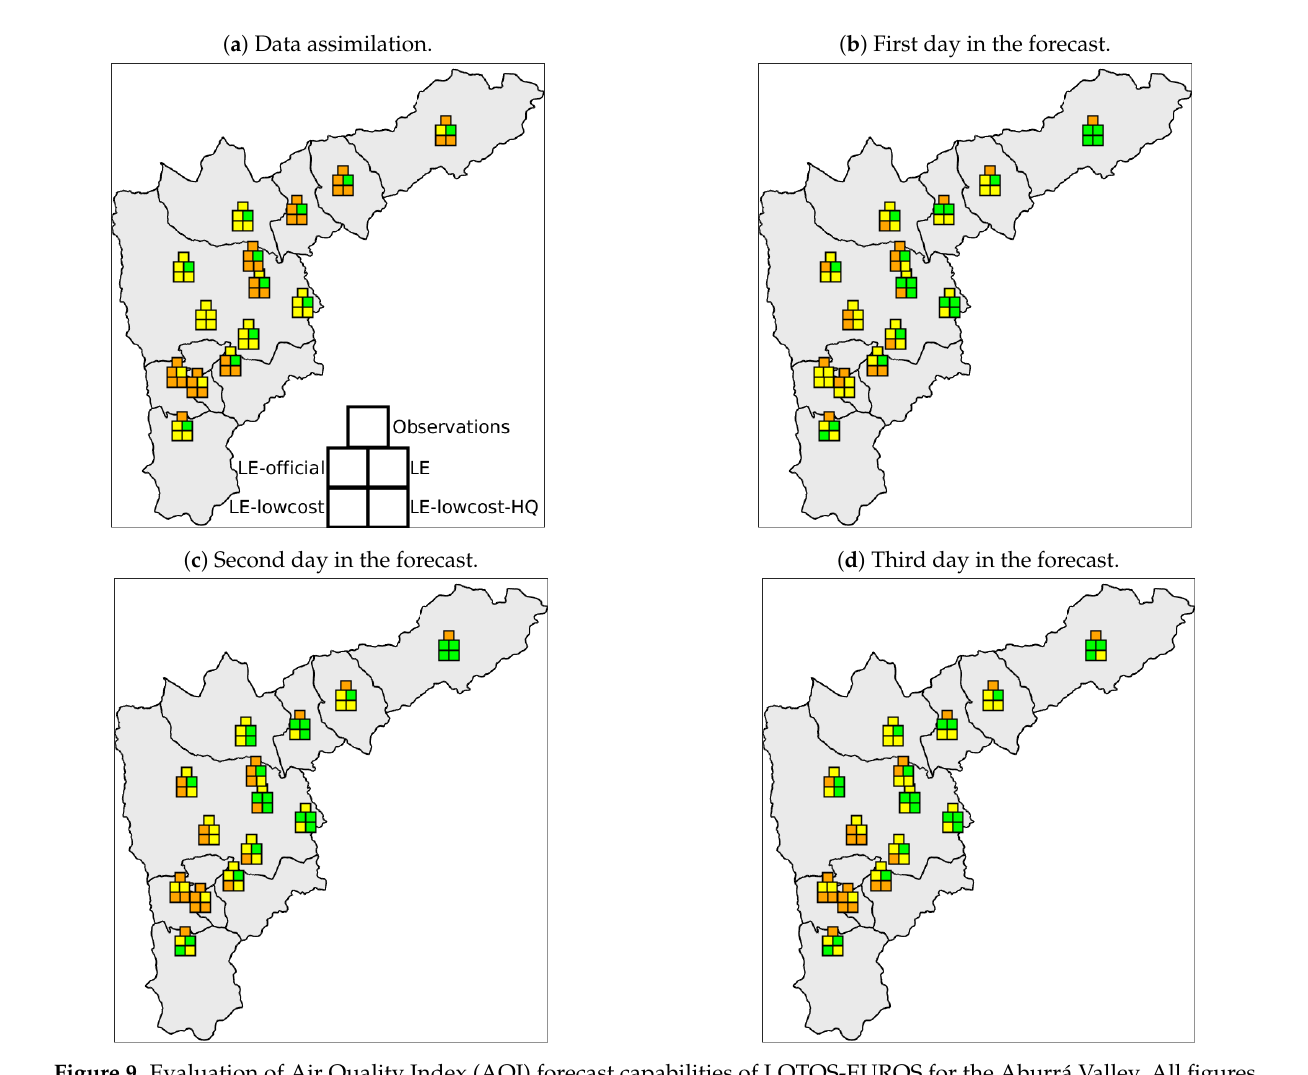
Figure 9. Evaluation of Air Quality Index (AQI) forecast capabilities of LOTOS-EUROS for the Aburrá Valley. All figures represent the forecasts and analysis for 12 March when it corresponded to analysis day ( a ), the first ( b ), second ( c ) and third ( d ) day within the forecasting window. The five-square markers are located at the geographical location of each of the official stations used for comparisons. The upper-center square is the AQI calculated from the observed PM values, against which all other values are compared; the middle-left inner square is the AQI predicted by the LE-official simulation; the middle-right inner square is the AQI predicted by the model without assimilation; the bottom-left inner square the AQI predicted by the LE-lowcost simulation; and the bottom-right inner square is the AQI predicted by the LE-lowcost-HQ simulation. The AQI definition is as in Table